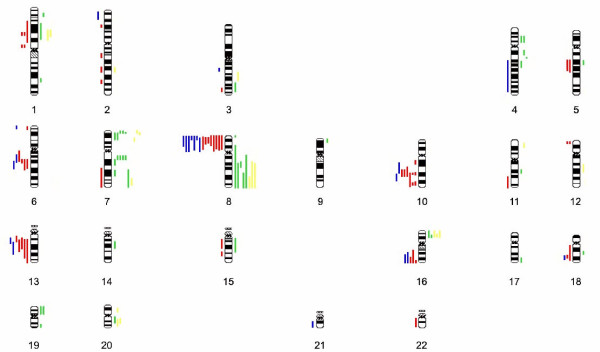
Chromosomal alterations observed for HPIN and CaP DNA samples. Blue bars indicate loss in HPIN and yellow bars indicate gain in HPIN. Red bars indicate loss in CaP and green bars indicate gain in CaP.